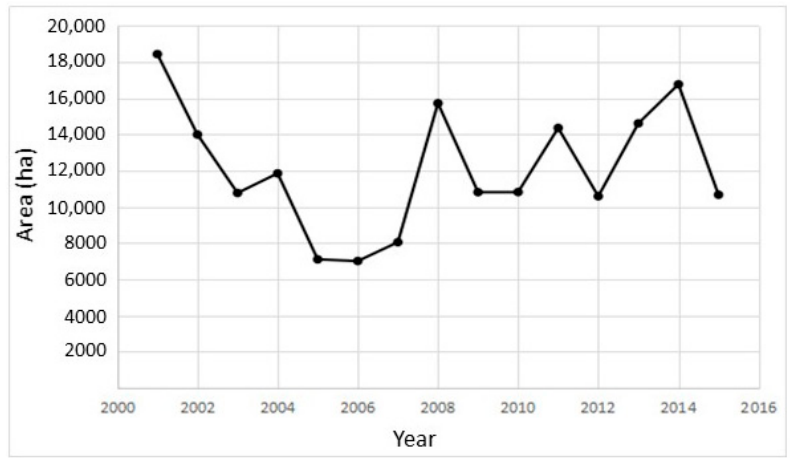
Figure 5. Annual expansion of irrigated cropland in China’s upper Ili River basin from 2000 to 2015. Eight major dams, all on the Ili’s upstream tributaries in China (Table 2), are sources of irrigation water and in many cases hydropower [89]. Dozens of smaller reservoirs have also been built in the Chinese territory of the Ili River basin [109]. As of 2012, the total reservoir capacity on the Chinese side was estimated to be 4893.6 million m 3 [110], roughly one-third of that represented